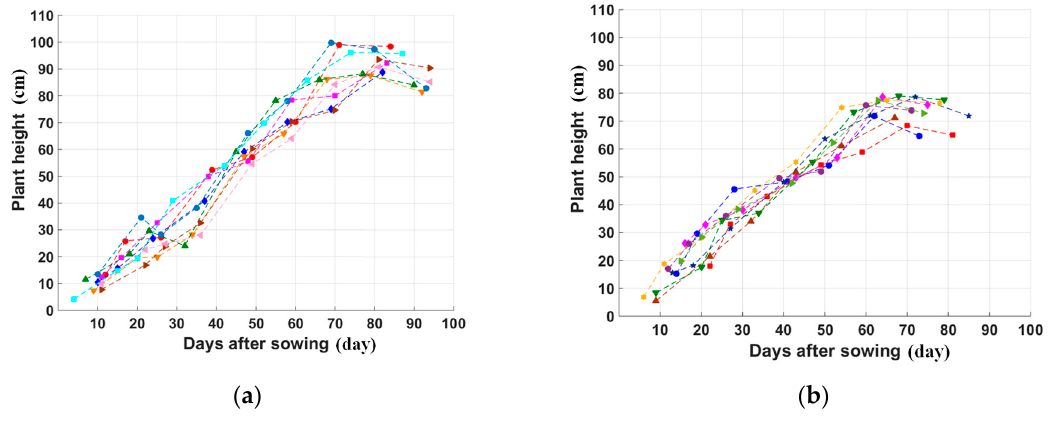
Figure 4. Temporal variation of plant height (versus days after sowing): ( a ) 9 sampling fields for long-cycle rice plants; ( b ) 9 sampling fields for short-cycle rice plants. The fields have been chosen to have close sowing dates and same planting practices.